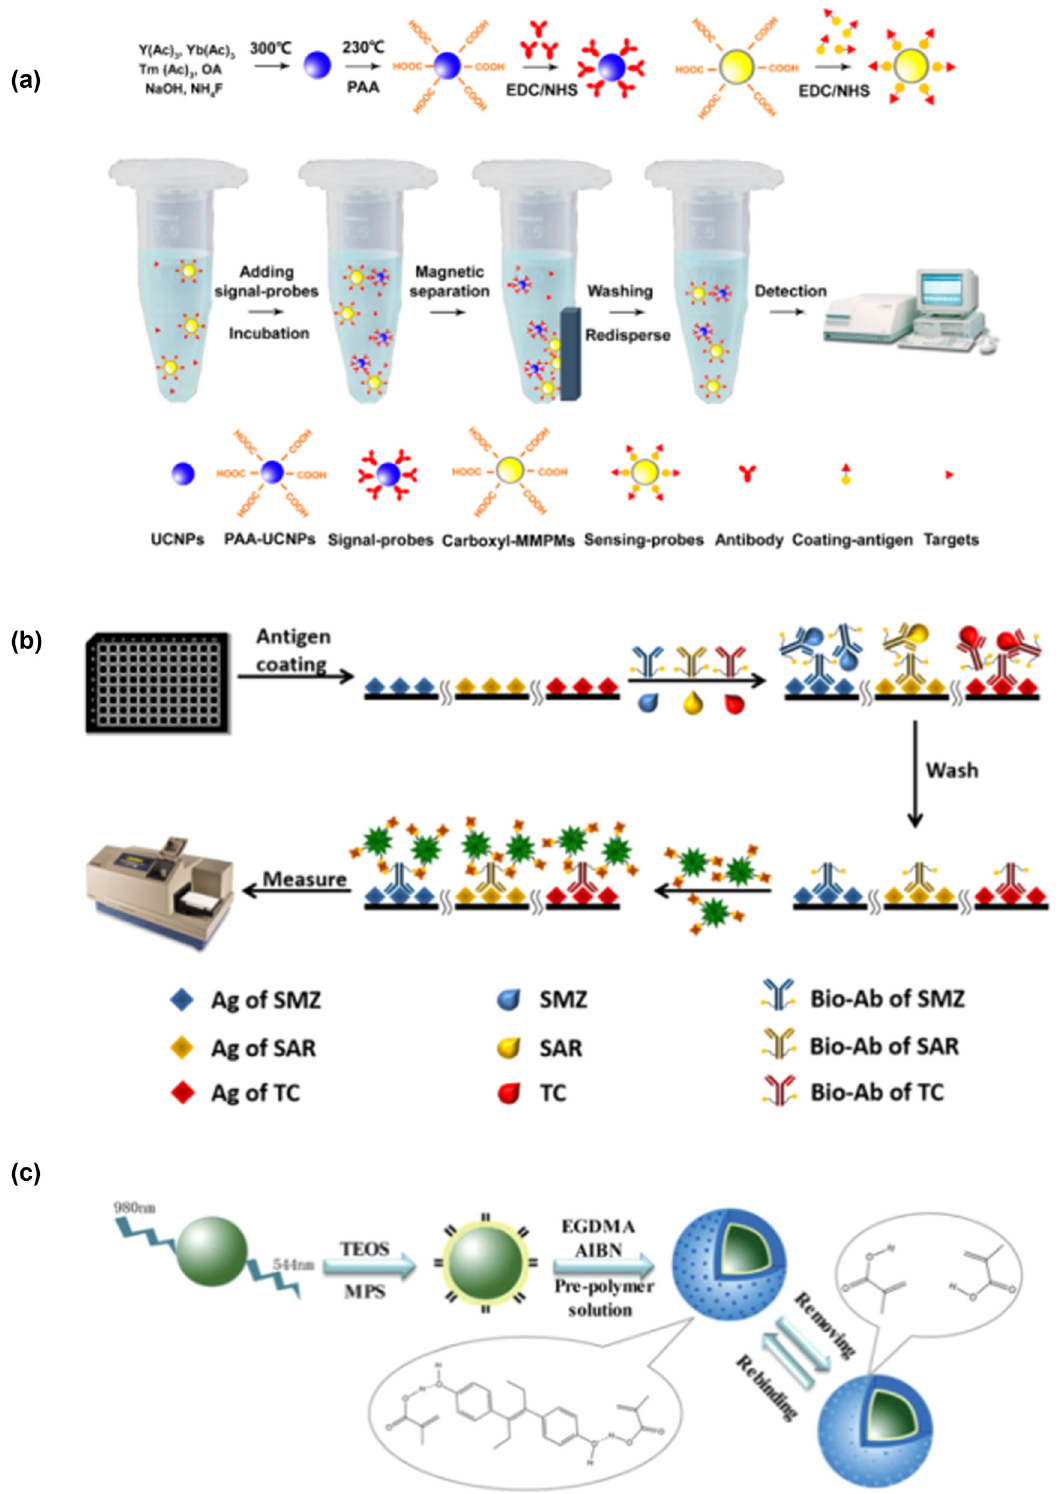
Figure 5: Schematic diagram of upconversion nanotechnology applied in the detection of antibiotics and hormones; ( a ) schematic diagram of detection principle of Sulfaquinoxaline ( SQ ) [ 130 ] ; ( b ) schematic diagram of avidin biotin complex immunosorbent assay for detection of three antibiotics based on controllable assembly of UCNPs [ 131 ] ; ( c ) schematic diagram of MIP - coated UCNPs preparation procedure [ 135 ]